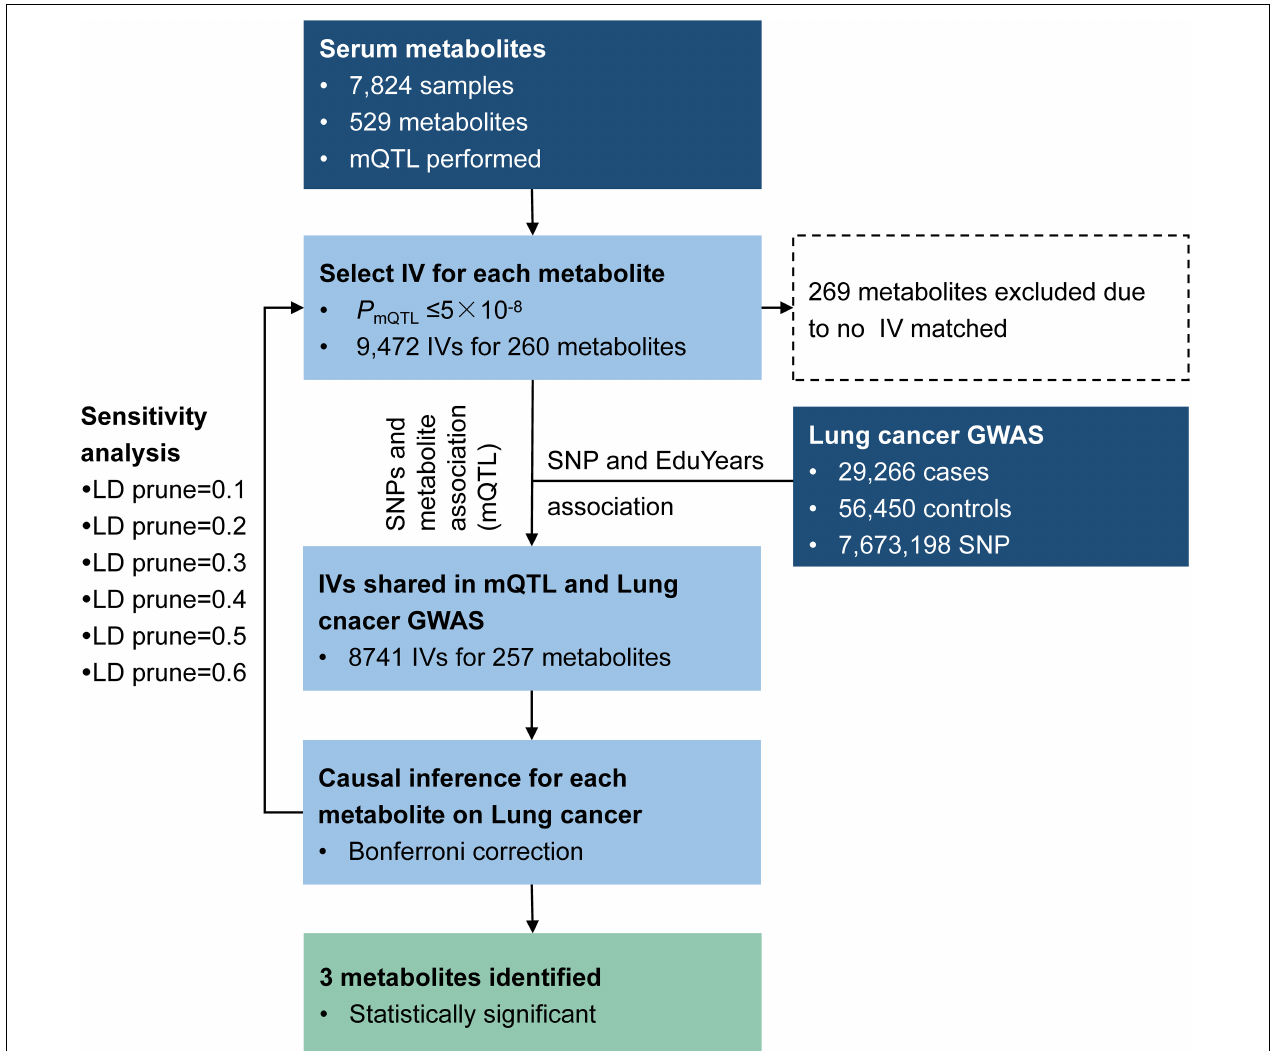
FIGURE 5 | Study workflow for educational attainment MR